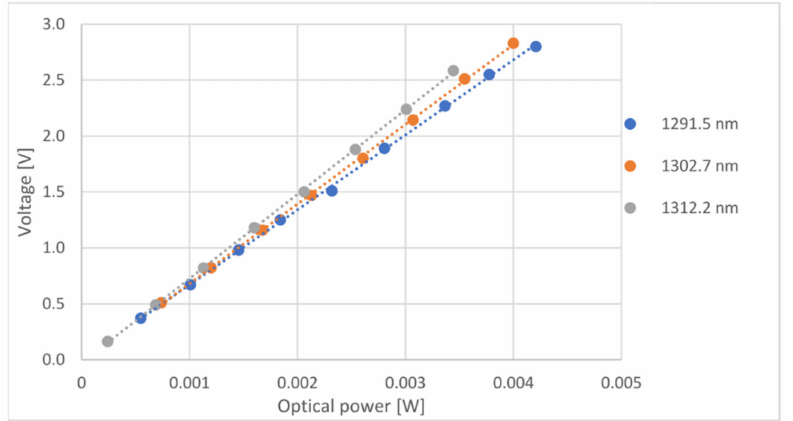
Figure 8. Relationship between the optical power received by the photodiode and the voltage at the transimpedance amplifier output for three distinct wavelengths.